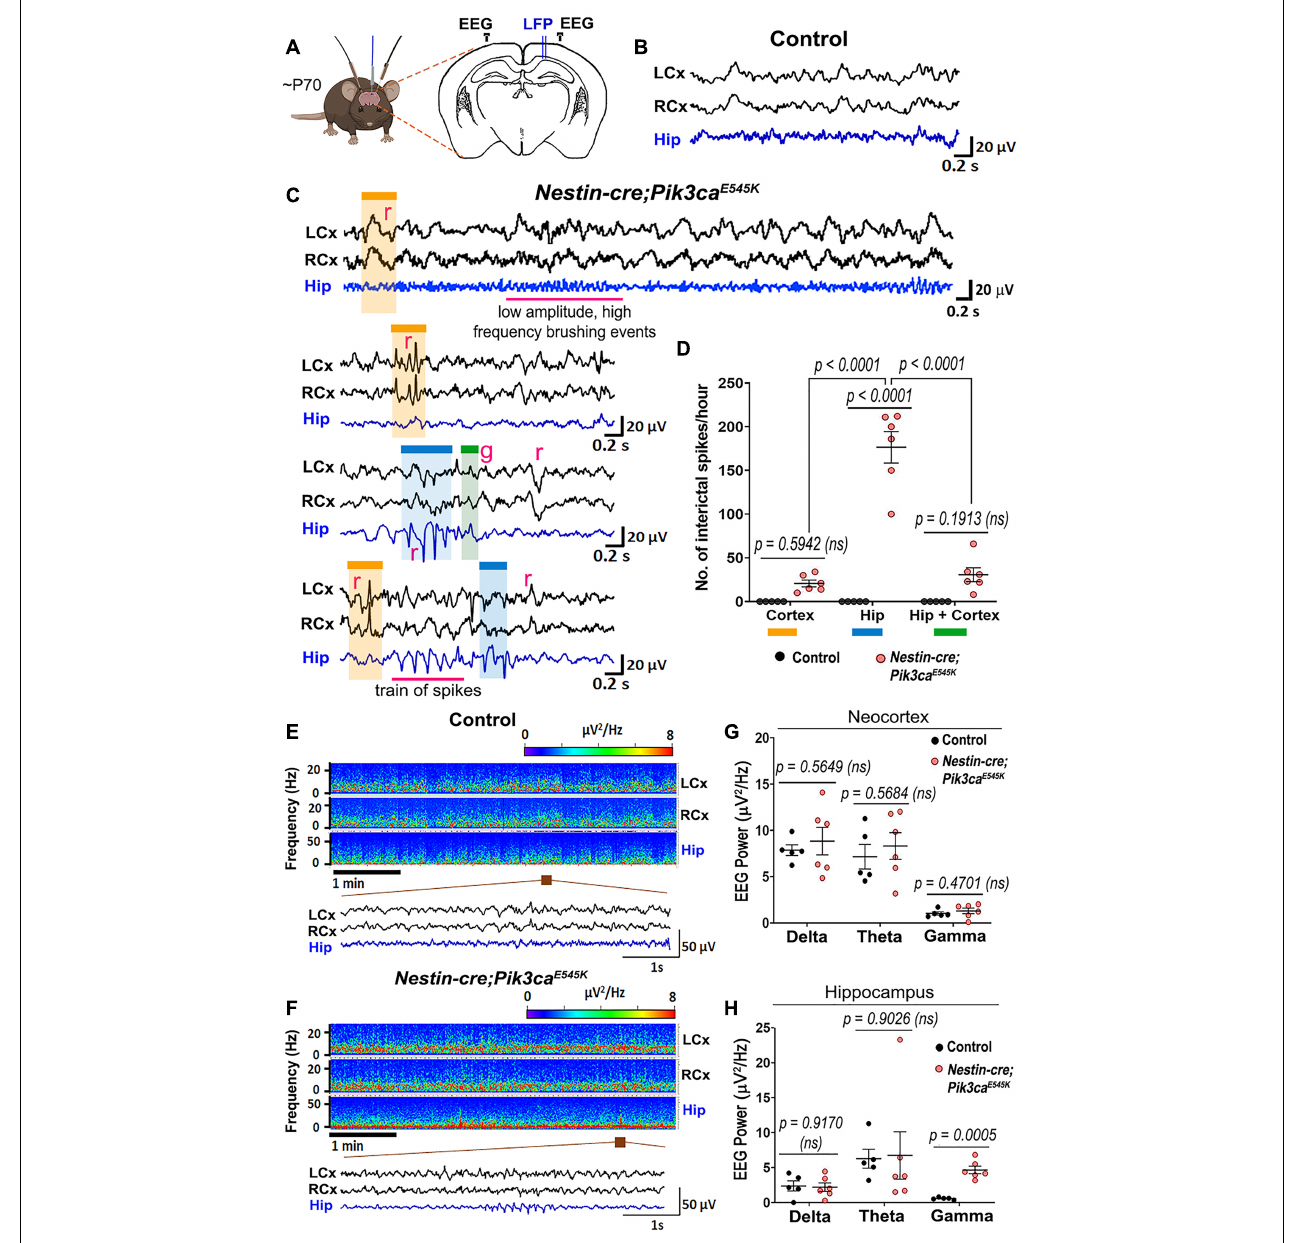
FIGURE 1 | Nestin-cre;Pik3ca E 545 K mutant brains show higher neural excitability. (A) Schematic shows electrode placement for EEG-ECoG recordings in ∼ P70 Nestin-cre;Pik3ca E 545 K and control littermates. LFP, local field potential. (B,C) Compared to controls, the mutants showed significantly higher frequency of regional (r) or generalized (g) spikes, train of spikes/polyspikes in neocortex (black traces) and hippocampus (blue traces). Low amplitude, high frequency brushing events were also observed in the hippocampus. (D) In the mutant, interictal spike frequency was significantly higher in the hippocampus (blue box), compared to those generated in neocortex (orange box) or generalized in both regions (green box) [ F = 46.65, degrees of freedom (df) = 27]. (E,F) Power spectrum analysis displayed increased activity in mutants, as emphasized in the representative magnified segments. (G,H) Mutant hippocampus demonstrated significantly higher activity in the gamma frequency range ( F = 3.932, df = 27; neocortex: F = 26.93, df = 27), where frequency bands as evaluated are: Delta: 0.5–5 Hz, Theta: 5–10 Hz, Gamma: 20–30 Hz. Data is represented as mean ± SEM scatter plots; differences were considered significant at p < 0.05; ns, not significant. Scale bars: 0.2 s, 20 µ V (B,C) ; 1 s, 50 µ V (E,F)